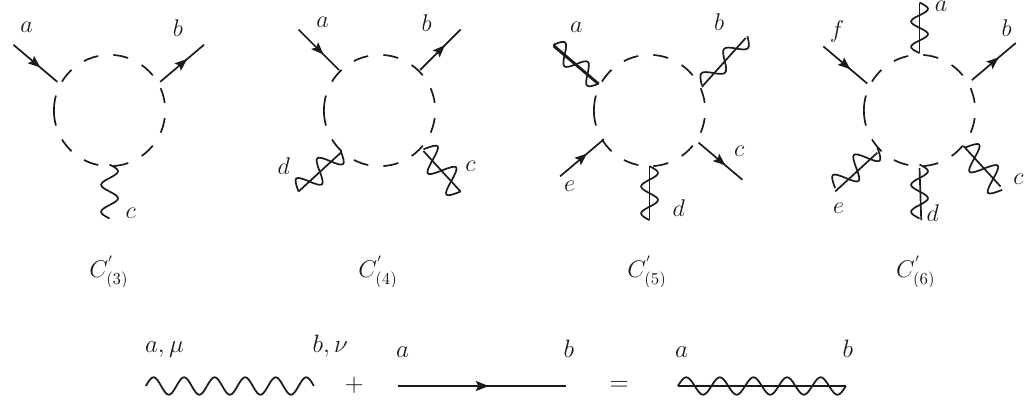
Figure 4 . Each building block is accompanied by its color coe(cid:14)cient of the type C used a generic dashed lines for hypermultiplets loops. In reality some part of the loop should be dashed and some dotted, in accordance with the Feynman rules. The wiggled/straight line stands for V or (cid:8) propagators, as explained in the second row of the (cid:12)gure.